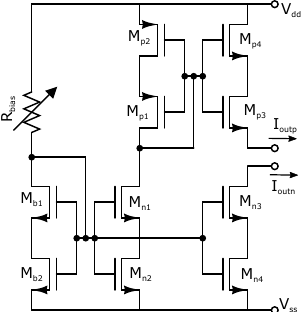
Figure 10. Proposed circuit to tune Iof f in in Figure